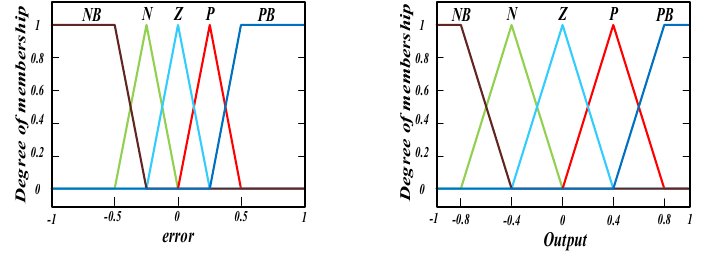
Figure 9. Inputs and output membership degree.